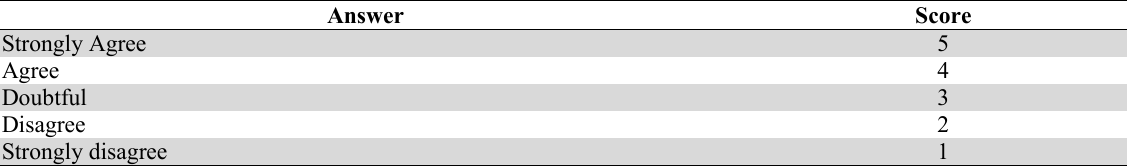
Score quality of respondents’ answers